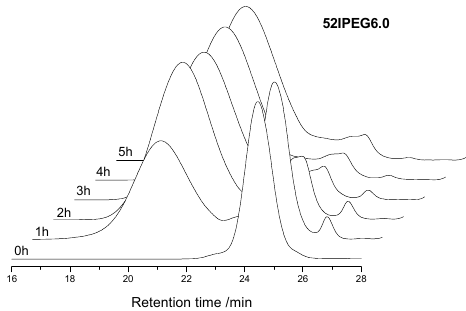
Figure 7. SEC spectra of 52IPEG6.0 with the time interval of 1 h.